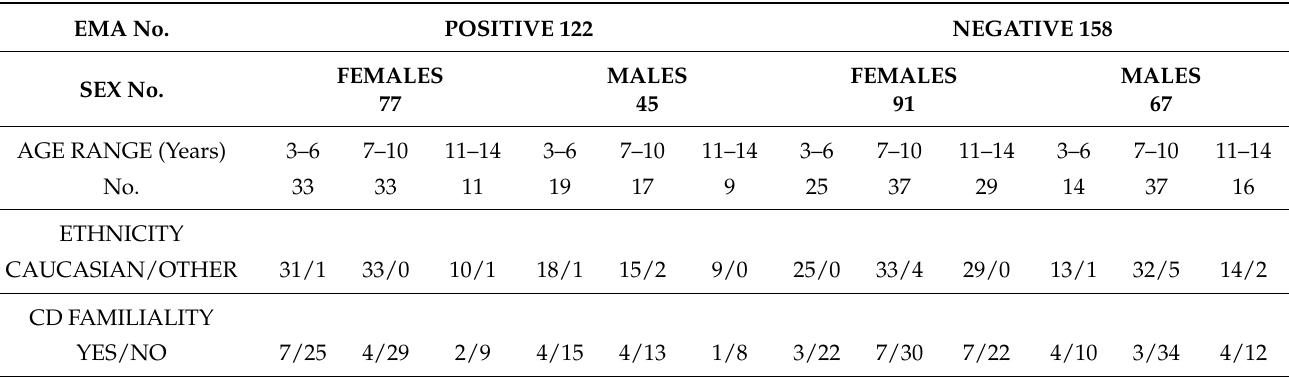
Table 5. Demographic data according to endomysial (EMA) results of 280 children who underwent further investigations in Malta.